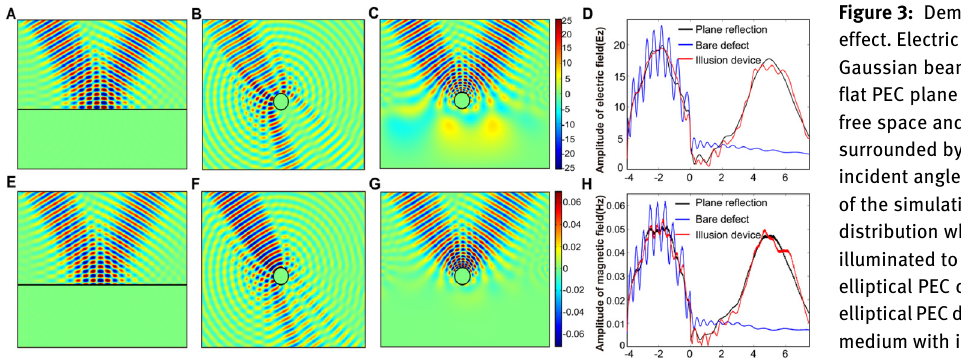
lateral shift of the re fl ected beam compared to the re fl ected